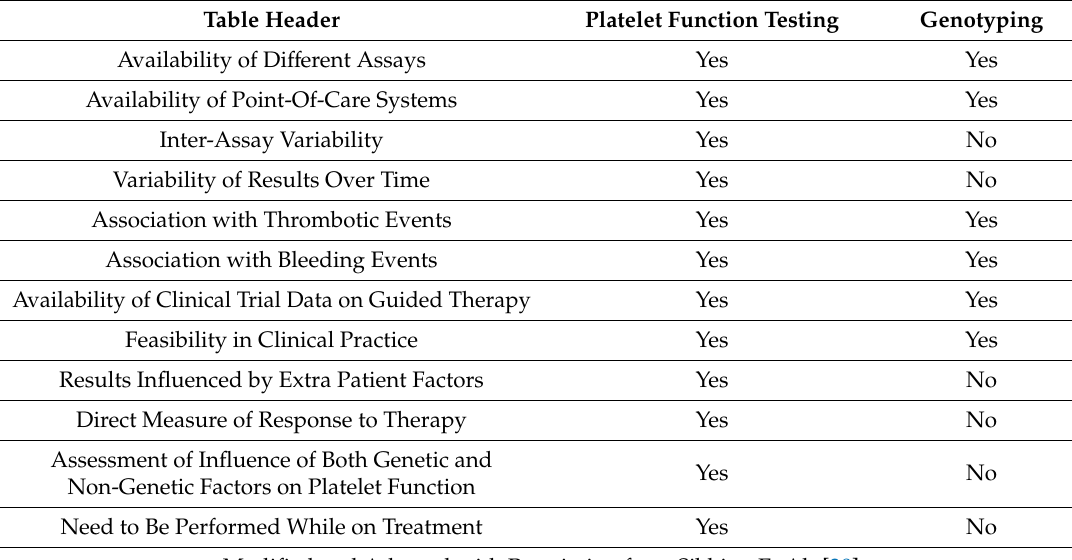
Table 3. Advantages and disadvantages of platelet function and genetic testing. Table Header Platelet Function Testing